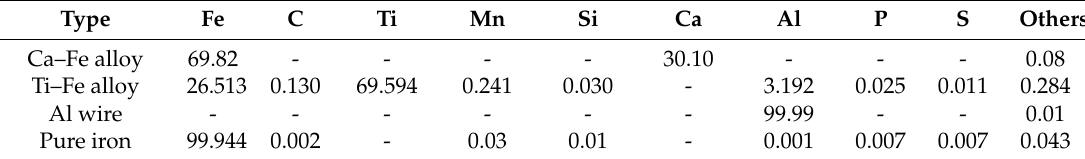
Table 1. The compositions of experimental materials (mass %).